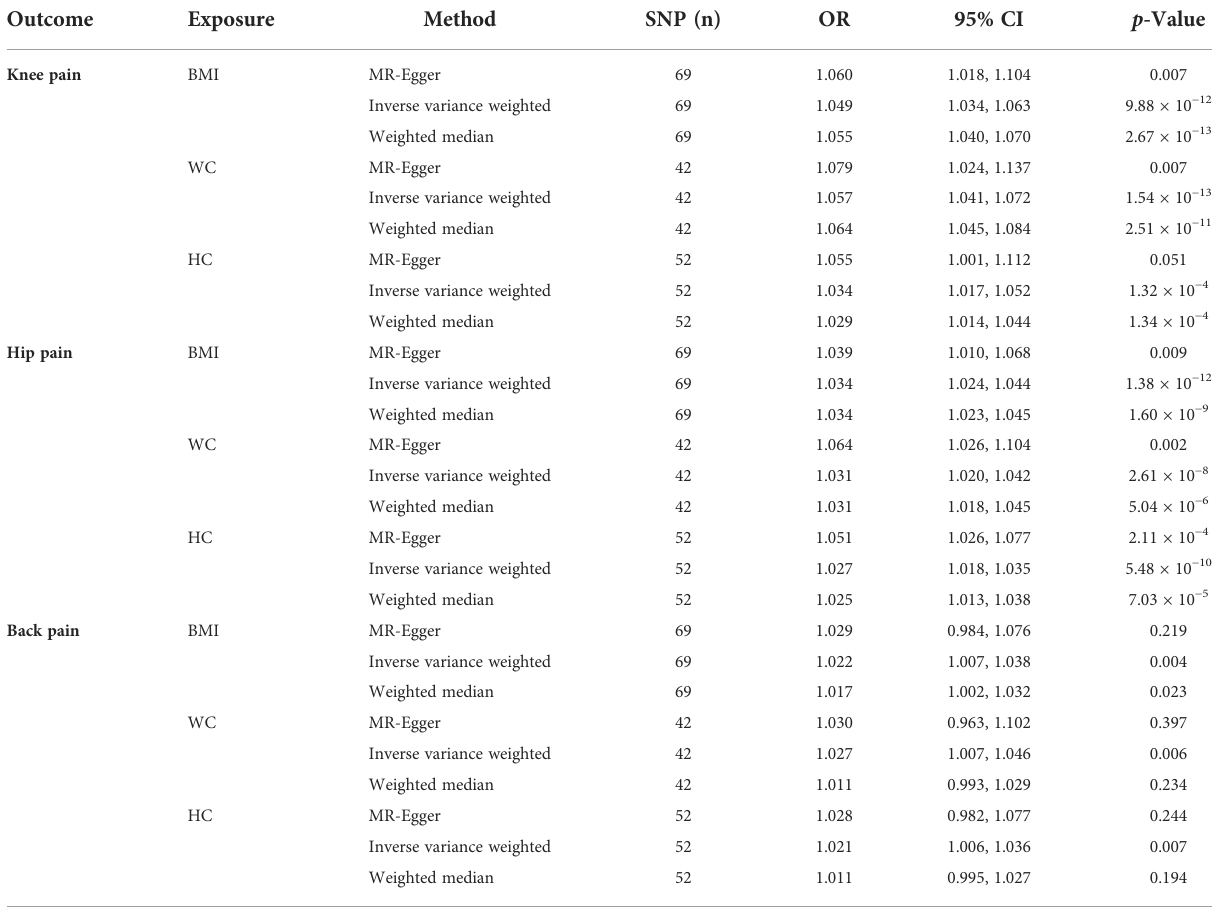
TABLE 1 The MR results regarding causal associations between obesity and chronic pain.